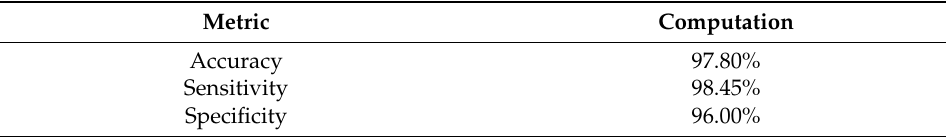
Table 6. Accuracy, sensitivity, and specificity of the proposed